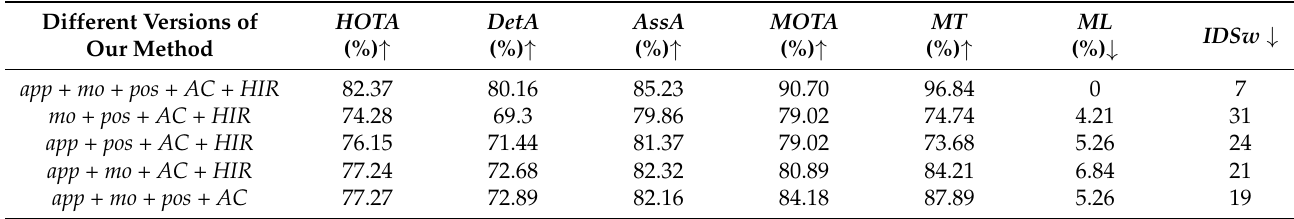
Table 2. Quantitative comparison of different versions of our